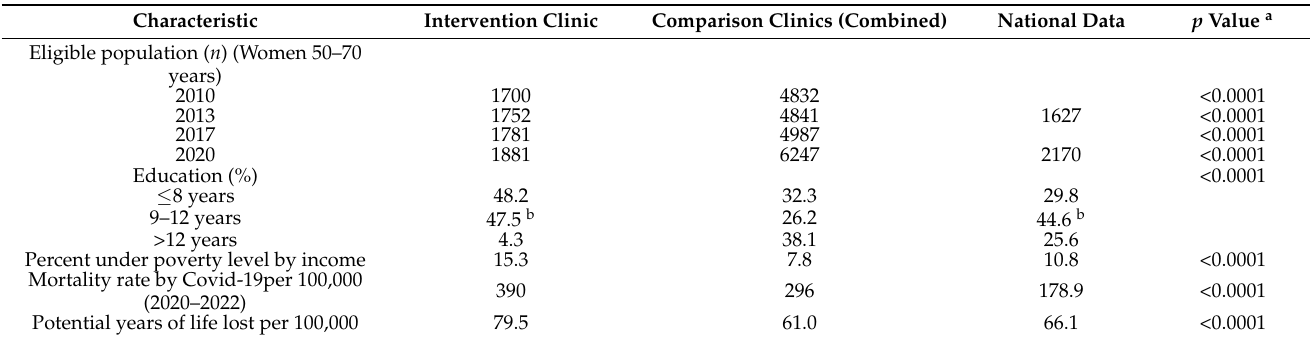
Table 1. Characteristics of the population in the intervention and comparison clinics.